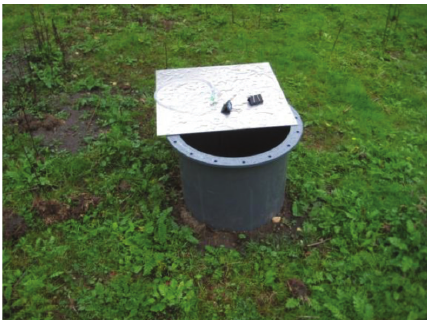
Figure 4: Flux chamber apparatus.